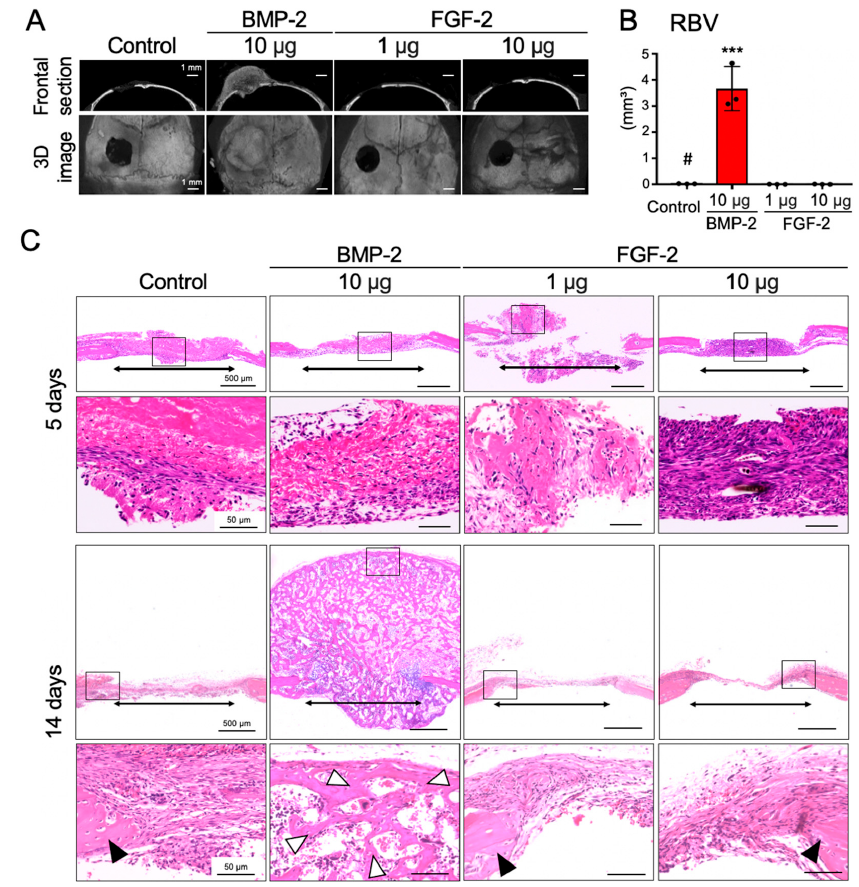
Figure 1. BMP-2, but not FGF-2, promotes repair of mouse calvarial defect. Collagen pellets containing BMP-2 (10 µ g) or FGF-2 (1 µ g, 10 µ g) or distilled water (DW, control) were transplanted into mouse calvarial defects. ( A ) Frontal section (upper panel) and 3D (lower panel) images of micro-CT, 14 days after transplantation. ( B ) Graph shows the quantitative analysis of the regenerated bone volume (RBV) ( n = 3, *** p < 0.001 versus control pellet (#). One-way ANOVA/Tukey). ( C ) HE-staining of frontal sections at the defect area at 5 days and 14 days after surgery. The results are representative of at least three independent experiments. Lower panels are high magnification images of the squares in the upper images. Two-way arrows, white arrowheads and black arrowheads indicate the bone defects, newly-formed bone and calvarial bone,